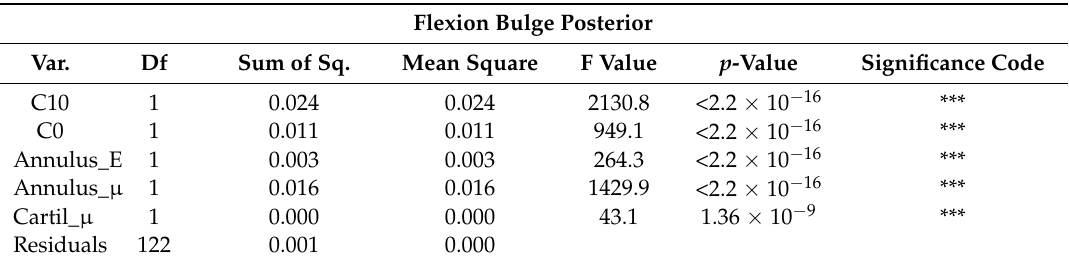
Table 23. ANOVA table for a flexion bulge posterior linear model.